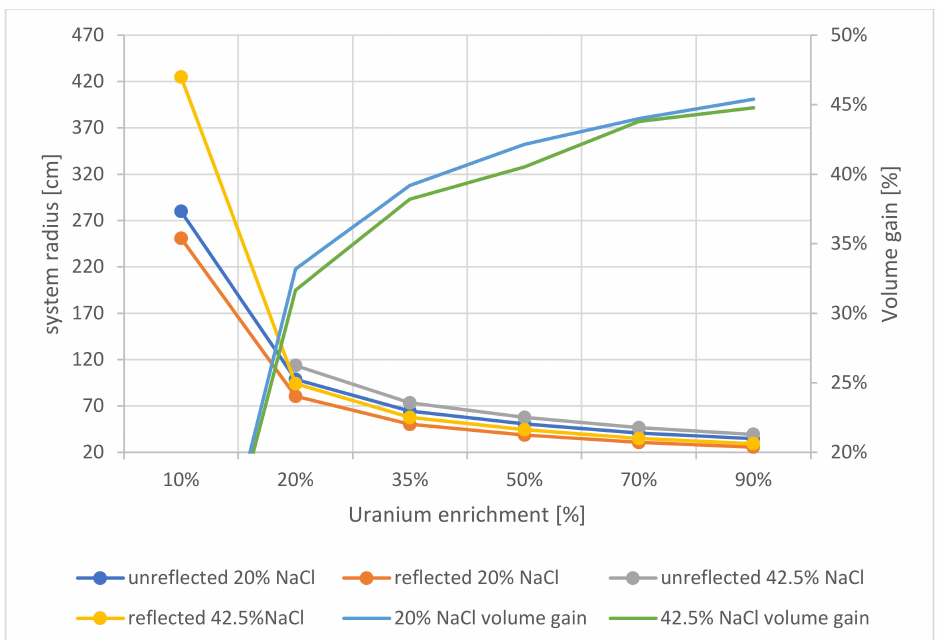
Figure 1. Generic 2D calculated system size depending on the fuel enrichment for the eutectic and the heavy-metal-rich system, and the fuel volume reduction achieved through a 30 cm thick NaCl reflector calculated with SCALE/POLARIS